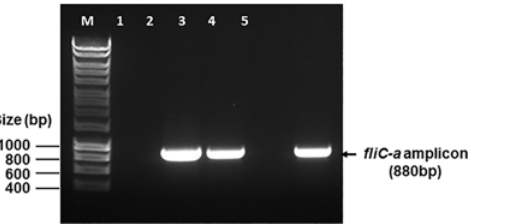
Fig 4. Detection of S . Paratyphi A using TSB — 2.4% ox bile – 20% blood culture PCR assay. Lanes: M, DNA marker; 1, negative PCR control; 2 and 3, positive blood samples; 4, negative blood sample; 5, positive PCR control.